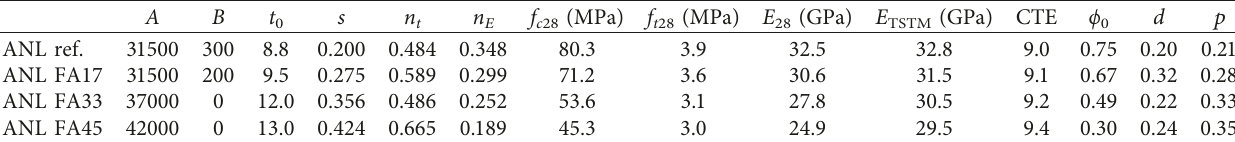
Table 3: Deduced material model